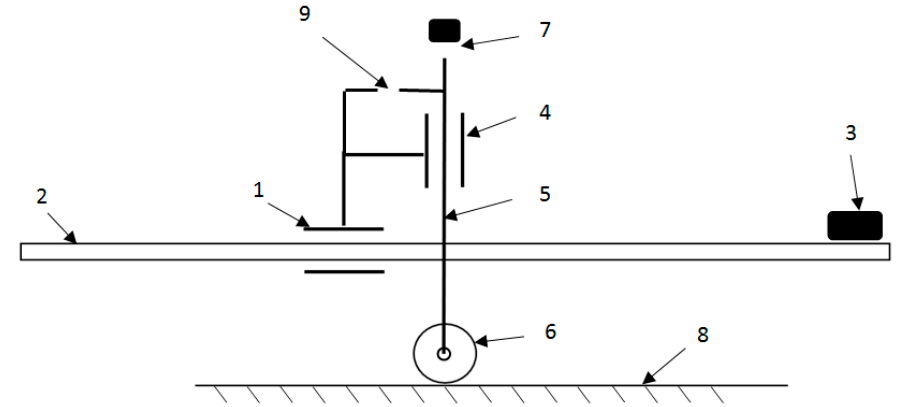
Figure 4. Designed test stand.